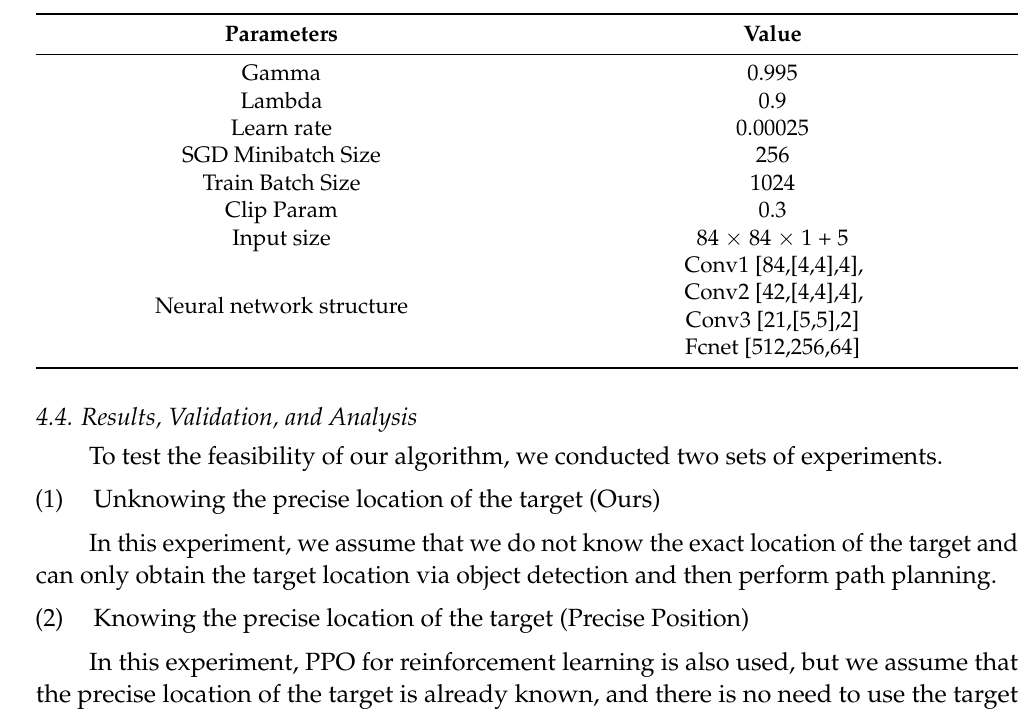
Table 2. The hyper-parameters of the FF-PPO algorithm.